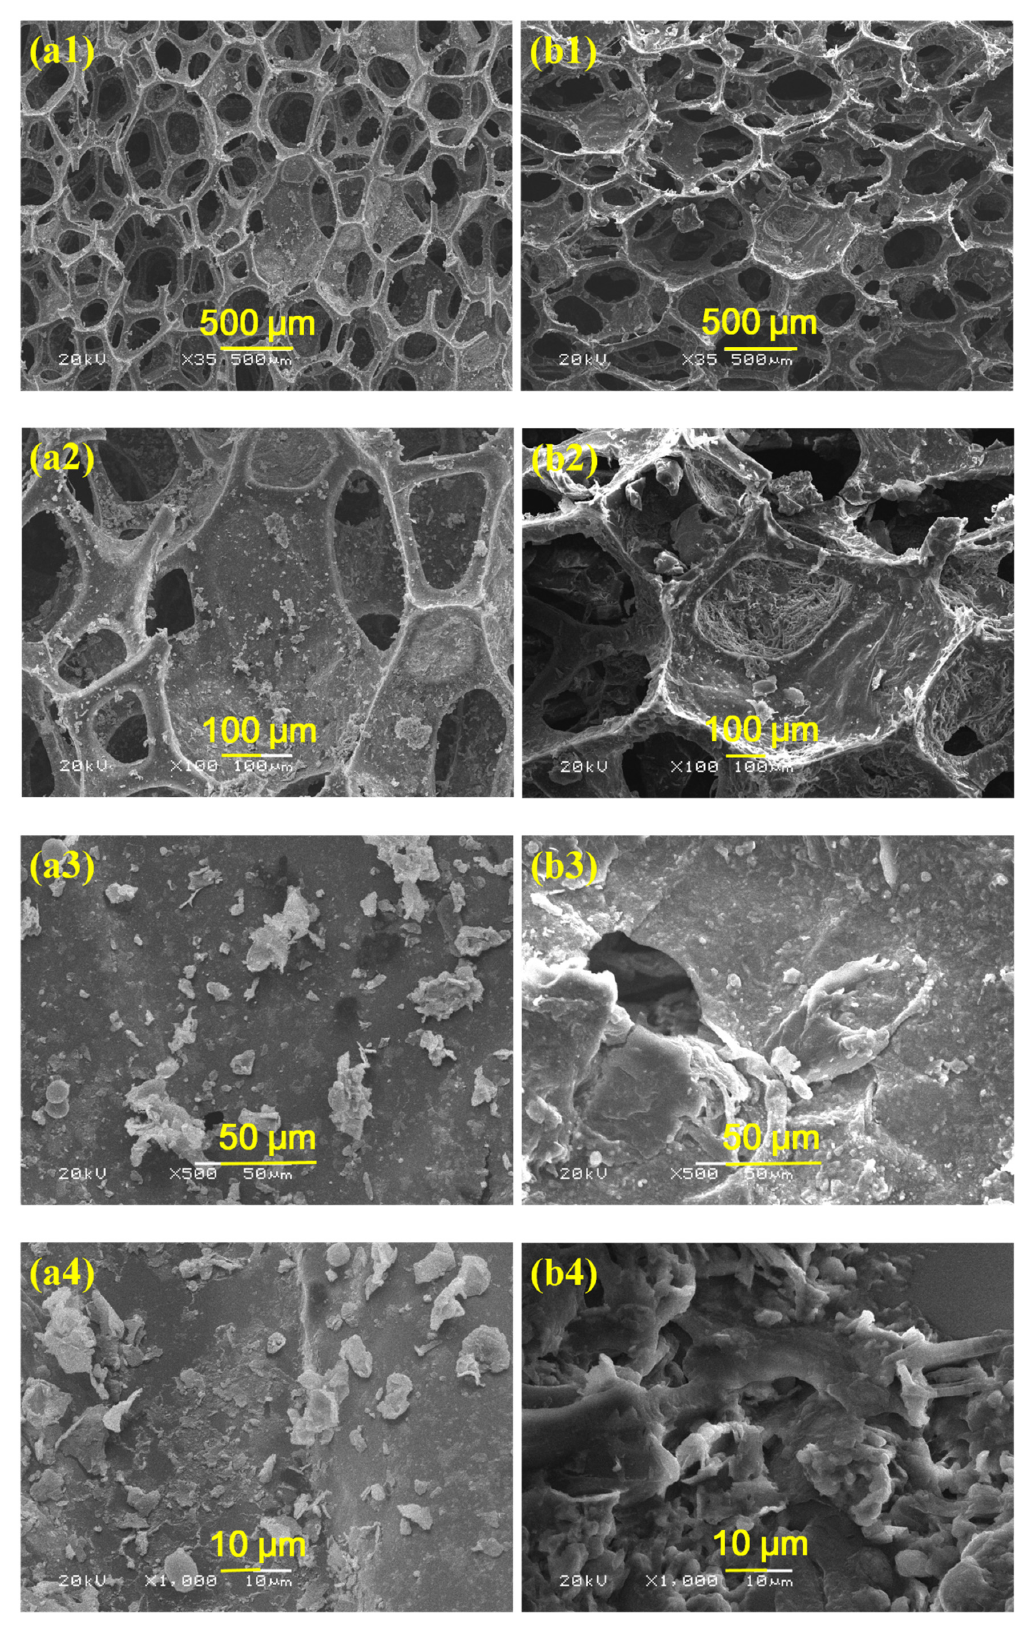
Figure 6. Morphology of composite sponge sample 1 (a1–a4) and composite sponge sample 2 (b1–b4).